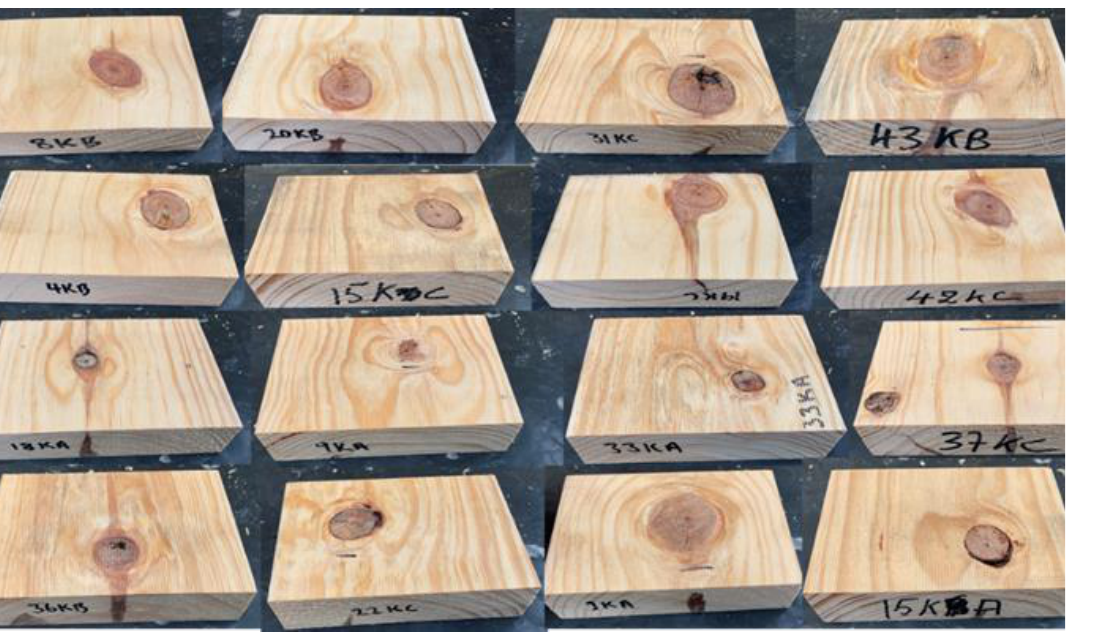
Figure 2. Sample preparation for aspect ratio ( a ) 3.0, ( b ) 4.5 and ( c ) 6.75 for Southern and Radiata pine.